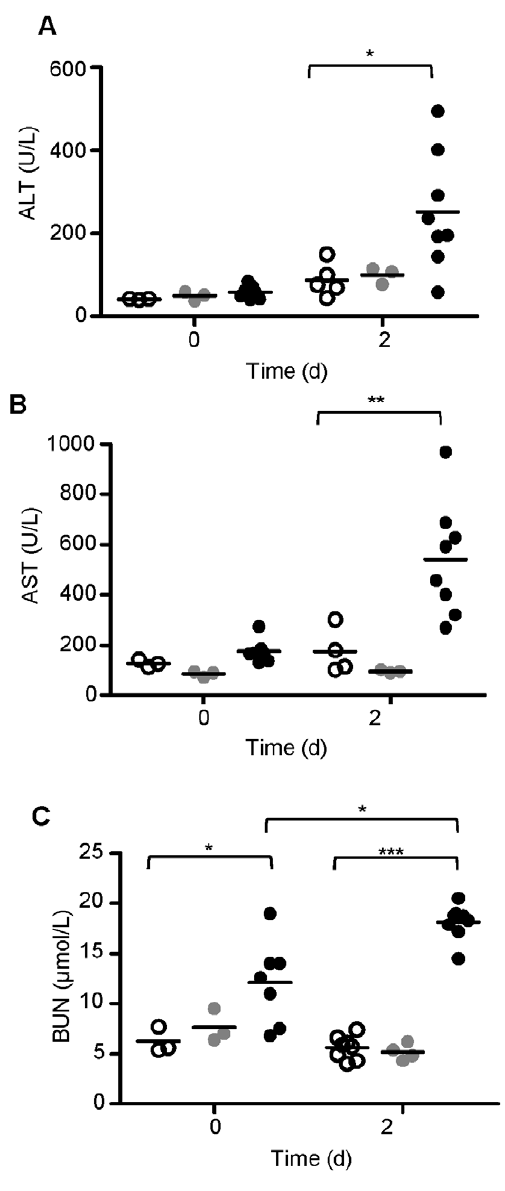
Figure 5. Ity16 mutant mice present elevated blood urea nitrogen (BUN), alanine transaminase (ALT) and asparatate transaminase (AST) during Salmonella infection. BUN (A), ALT (B) and AST (B) levels were measured at day 0 (prior to infection) and day 2 post infection in 7 week old Ank1 + / + wild type, Ank1 + /Ity16 heterozygous and Ank1 Ity16/Ity16 mutant mice. The values for each individual mouse are shown (n=3–8 per genotype). Wild type mice are represented by open circles, heterozygous by gray circles and Ity16 mutant by black circles. The high levels of BUN levels detected in mutant mice at day 0 most probably reflect the nephrotoxicity of iron accumulation in the kidney. During infection BUN, ALT and AST levels increased in mutant mice denoting kidney and liver damage. An *represents a P-value of less than 0.05; *** represents a P-value of less than 0.0001. doi:10.1371/journal.pone.0055331.g005 Mutations in the ANK1 gene accounts for about 50% of genetically defined cases of HS and most cases of HS associated with ANK1 mutations [19]( . 80%) show a dominant mode of inheritance [12]. In HS and in mice lacking ANK1, the consequence of the ineffective erythropoiesis, extramedullary hematopoiesis and re-